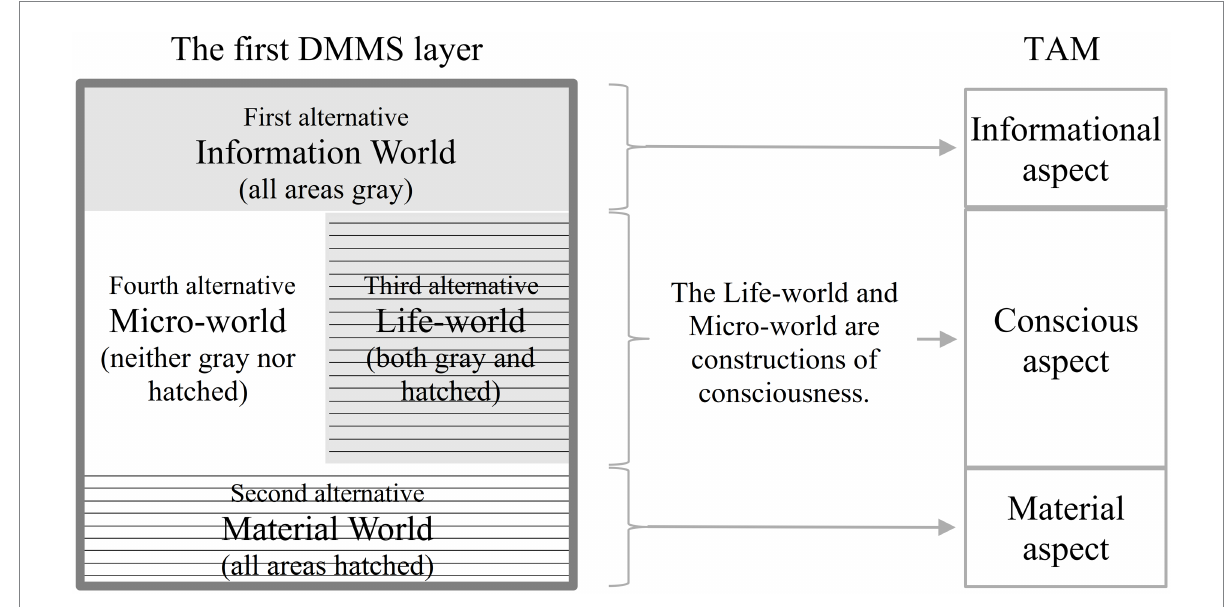
FIGURE 6 The first Dialectical Mandala Model of Self-cultivation (DMMS) layer mapped onto the triple-aspect monism (TAM)